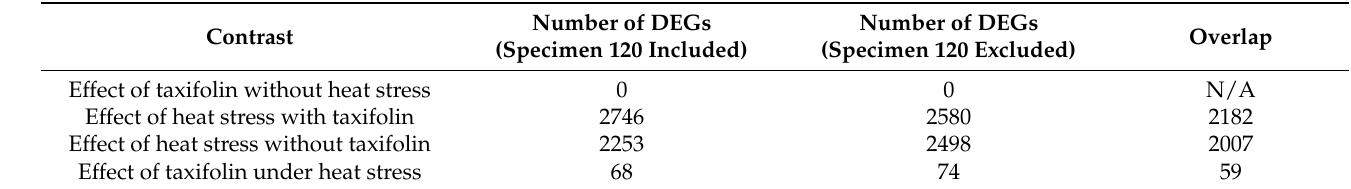
Table 2. The number of differentially expressed genes in various contrasts including or excluding specimen